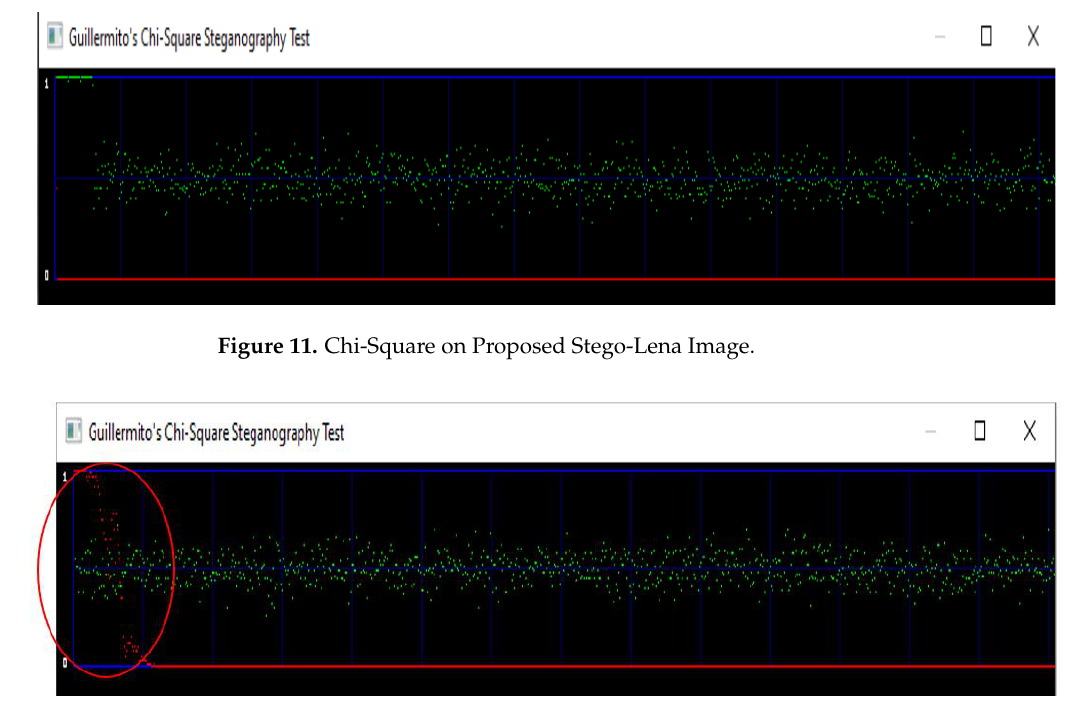
Figure 12. Chi-square 1-Kb of hidden data detected in a random image .